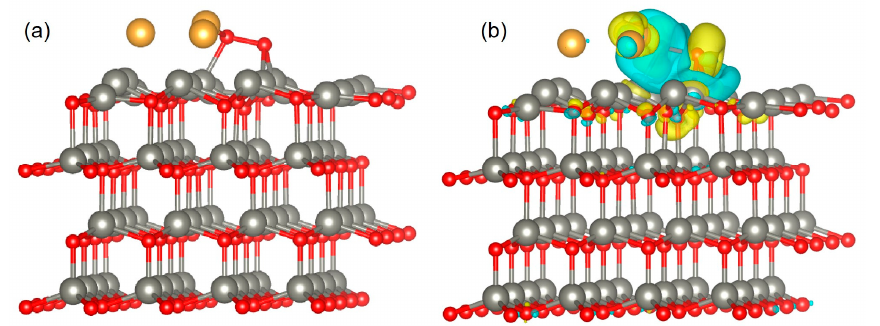
Figure 10. ( a ) Optimized configurations before O 2 molecule adsorption on Au/ZnO surface. ( b ) Optimized configurations after O 2 molecule adsorption on Au/ZnO surface and surface charge density change.